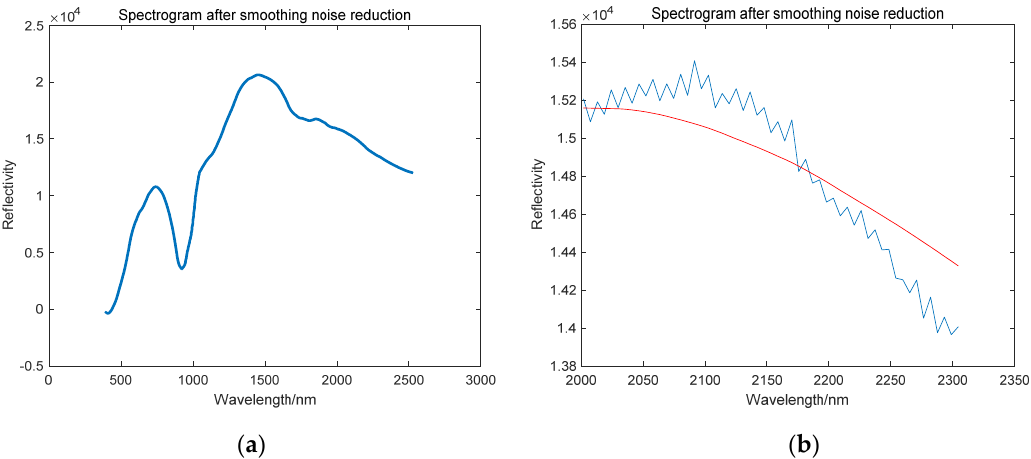
Figure 5. Results of wavelet transform and noise reduction: ( a ) L6 full-spectrum smoothing diagram;